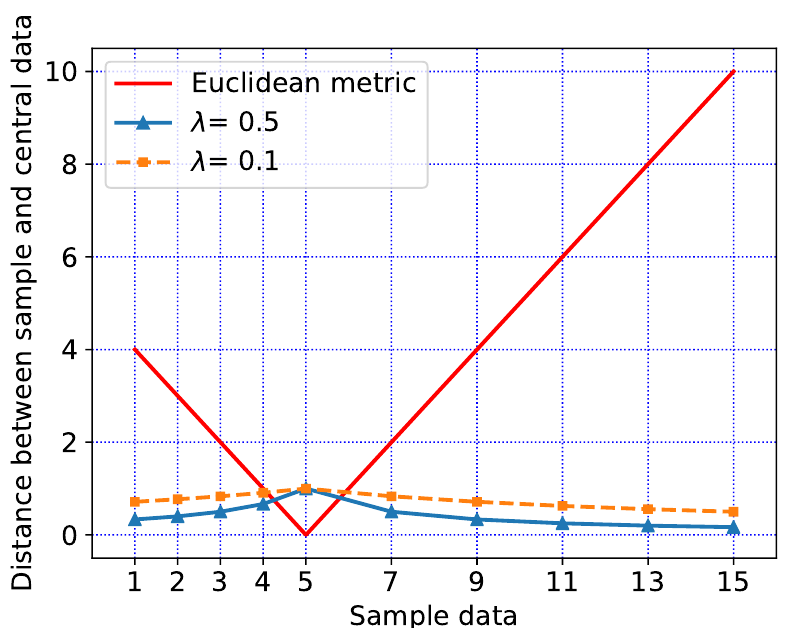
Figure 4. Fuzzy membership